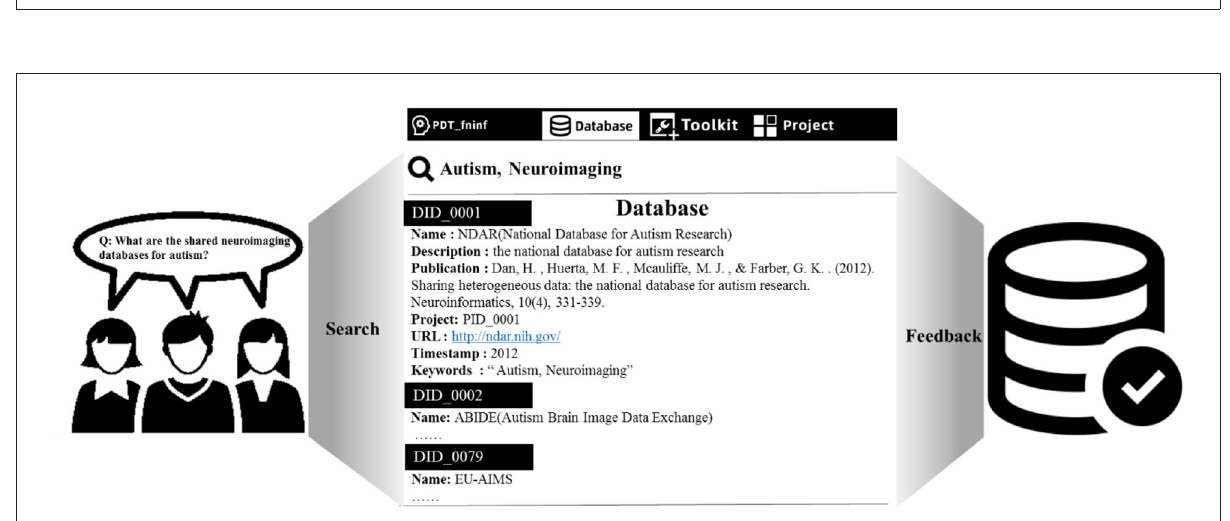
FIGURE5 Query the neuroimaging database of autism from the knowledge